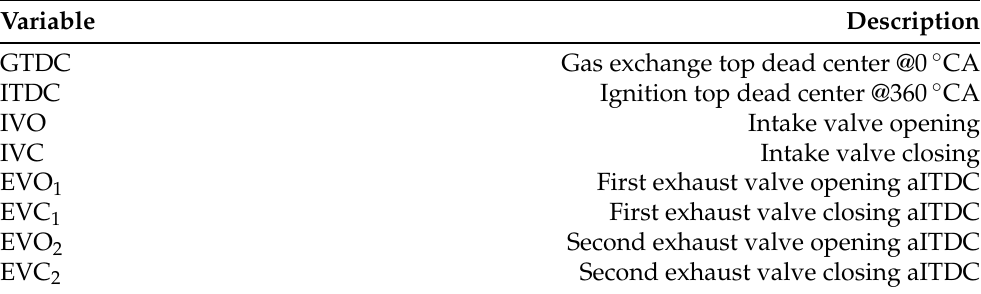
Table 3. Nomenclature relevant to valve